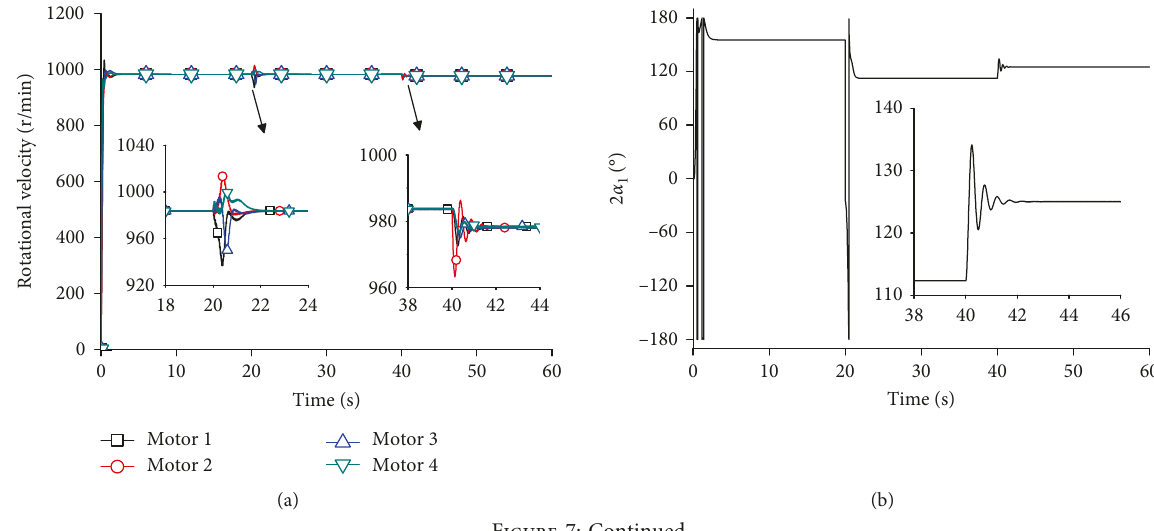
Figure 6: Results of computer simulations for η between vibrators 1 and 2; (c) phase difference between vibrators 2 and 3; (d) phase difference between vibrators 3 and